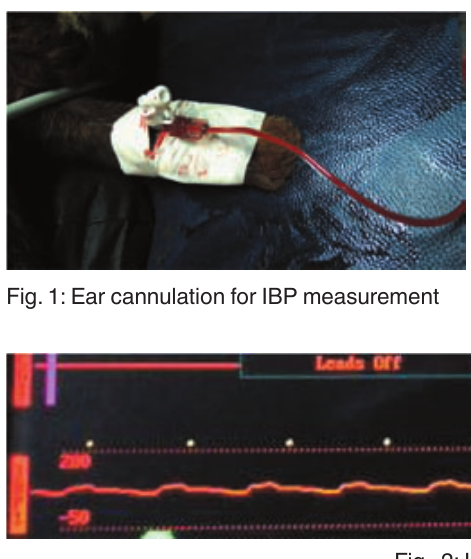
table 1: NIBP and IBP values obtained during anaesthesia non-invasive blood pressure monitoring time